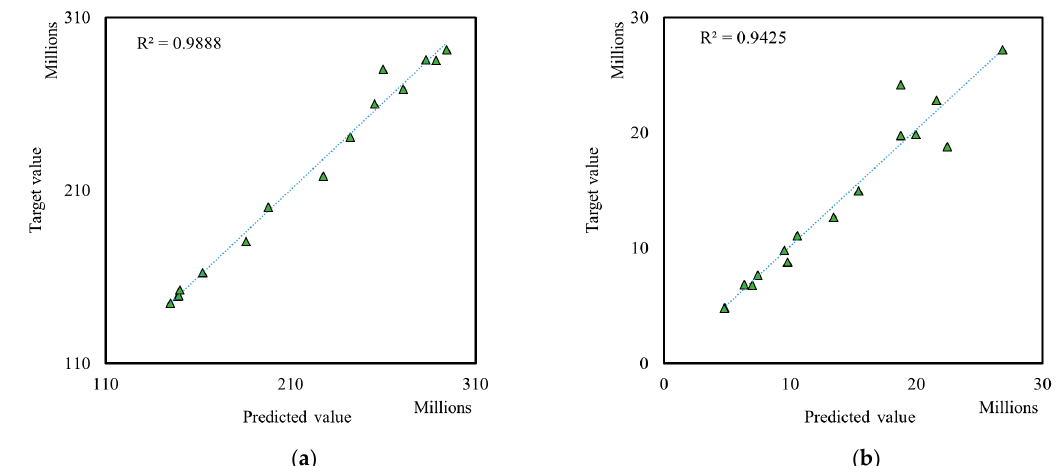
Figure 4. The coefficient of determination of the ANFIS model for livestock and agricultural production prediction. ( a ) Livestock Production; ( b ) Agricultural Production. Table 6. Prediction of agricultural and livestock production in Iran.